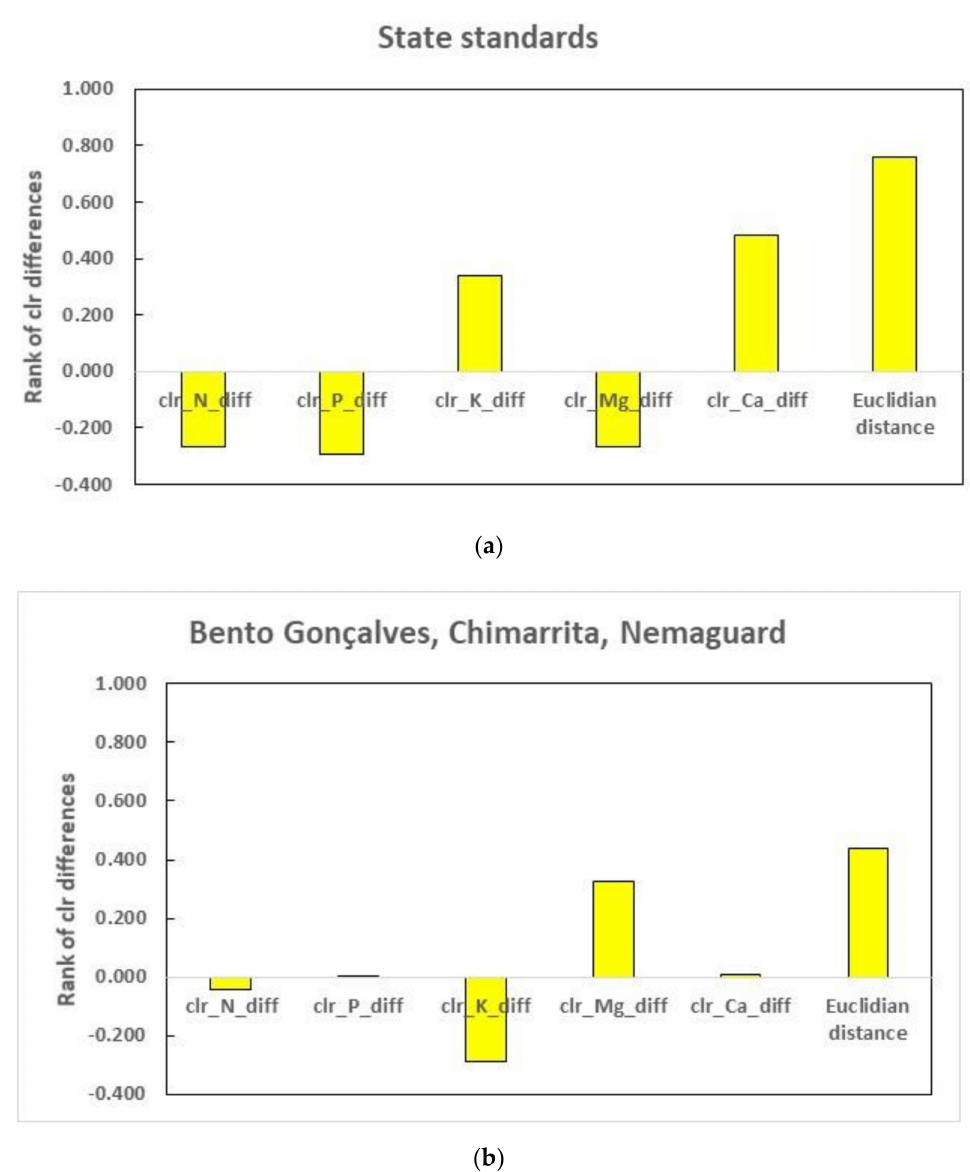
Figure 3. Histograms showing contrasting macronutrient diagnoses of a low-yielding peach orchard between ( a ) state standards and ( b ) the closest neighbor in Bento Gonçalves, Rio Grande do Sul, Brazil (same location and cultivar, similar soil properties and number of chilling hours). The centered log ratio ( clr ) di ff erences are computed as clr values of the diagnosed specimen (yield of 8.9 Mg ha − 1 ) minus the corresponding clr values of (left) state standards (no yield target indicated) or (right) the closest successful specimen (yield target of 30.4 Mg ha − 1 ). The Euclidian distance is computed across clr di ff erences. Negative di ff erences between defective and successful specimens indicate relative shortage. Positive di ff erences indicate relative